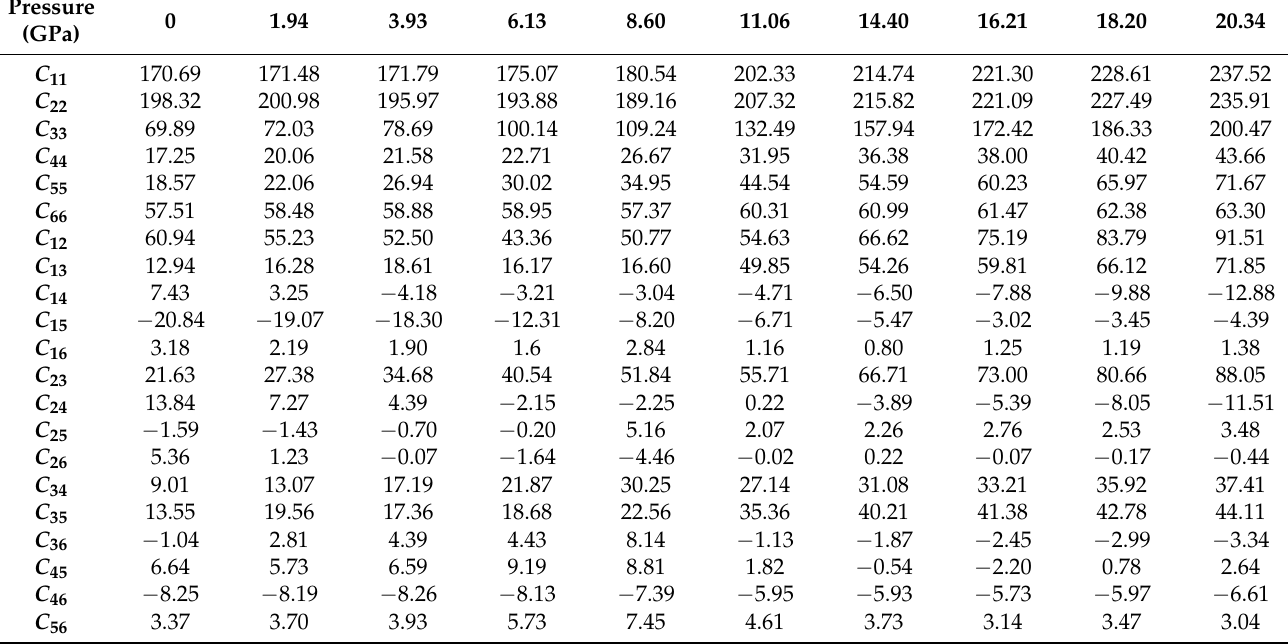
Table 12. The calculated elastic constants C ij of the Mg-MMT under